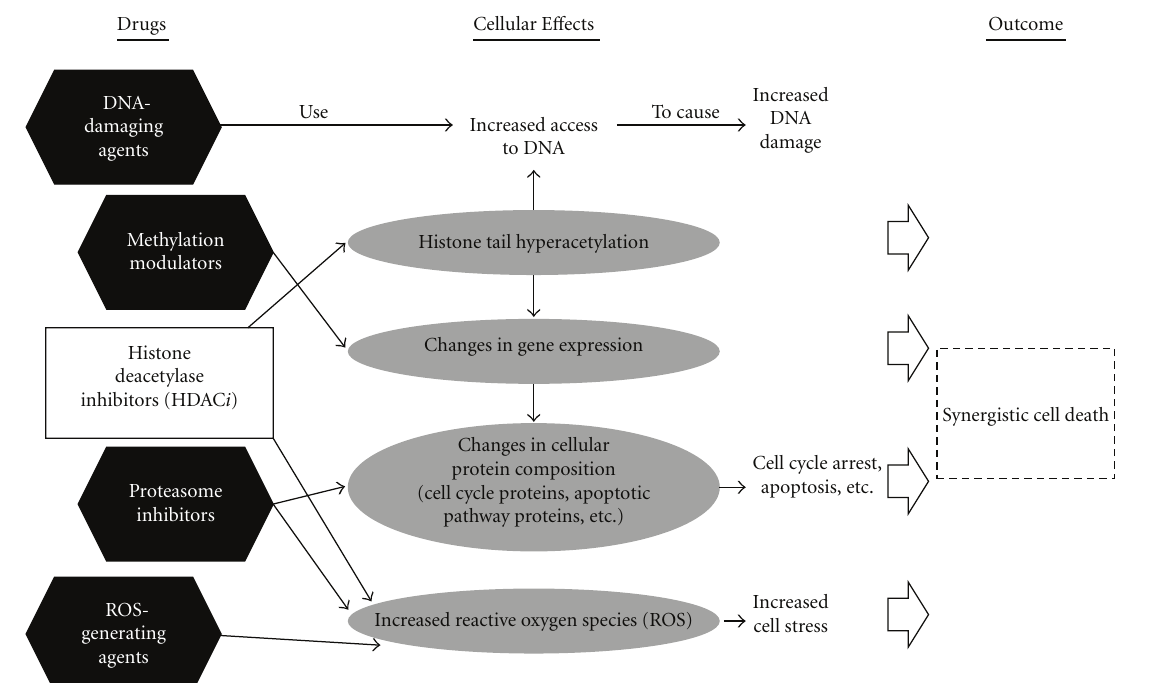
Figure 4: Several therapeutic combinations with HDACi show promising results. Some agents which have been shown to cause synergistic cell death when combined with HDACi include (1) DNA-damaging agents, such as radiation and many chemotherapies, which may take advantage of the increased access to DNA, provided by the “loose” chromatin arrangement after HDACi treatment, to cause increased DNA damage, (2) modulators of methylation, such as histone demethylase inhibitors and DNA methyltransferase inhibitors, which have been shown to contribute changes to the methylome that act synergistically with the actions of HDACi, (3) proteasome inhibitors, which increase cellular stress and lead to production of reactive oxygen species, can synergize with HDACi, and (4) ROS-generating agents, such as adaphostin, work with HDACi to amplify ROS production, adding to the already increased ROS levels in cancer cells until toxic levels lead to cell